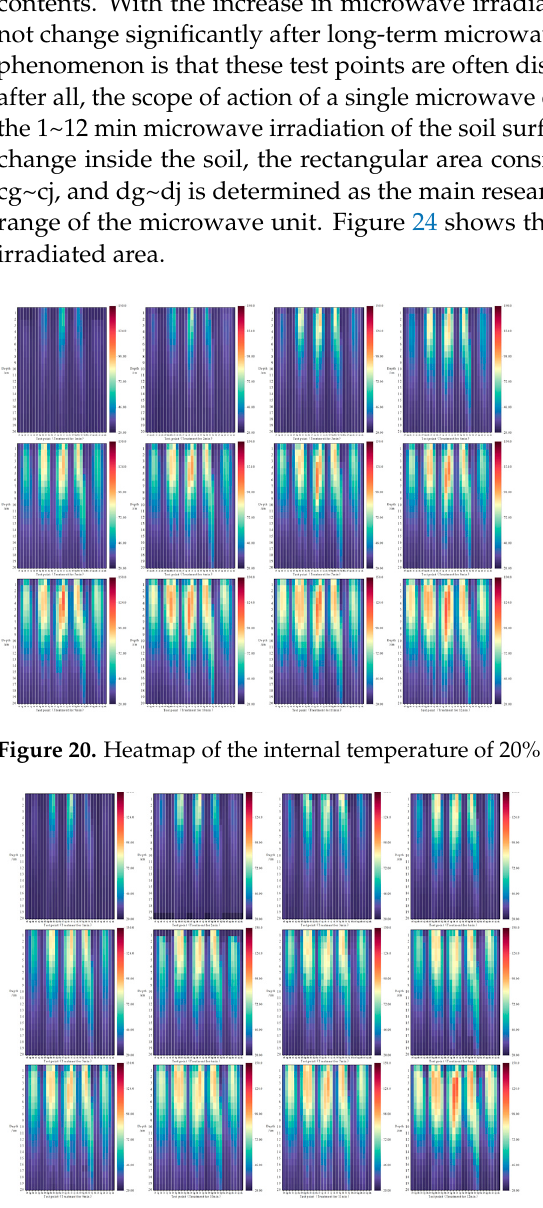
Figure 21. Heatmap of the internal temperature of 20% black soil under microwave irradiation.